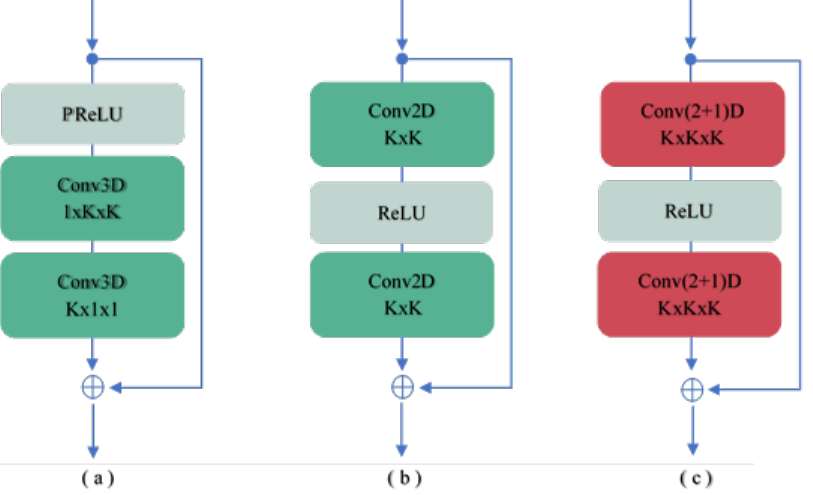
Figure 2. Comparison of ( a ) FSTRN [11] 3D residual block, ( b ) EDSR [21] 2D residual block, and ( c ) the proposed spatio-temporal convolutional residual